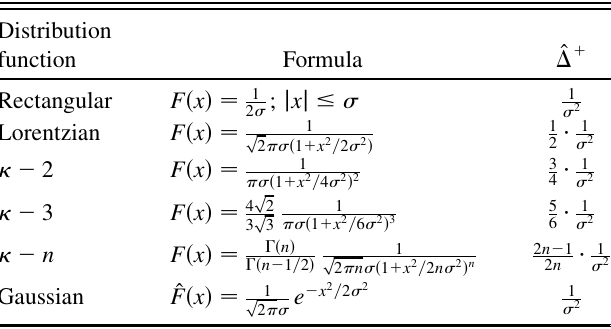
TABLE I. Cutoff frequency of FEL with bell-shaped energy